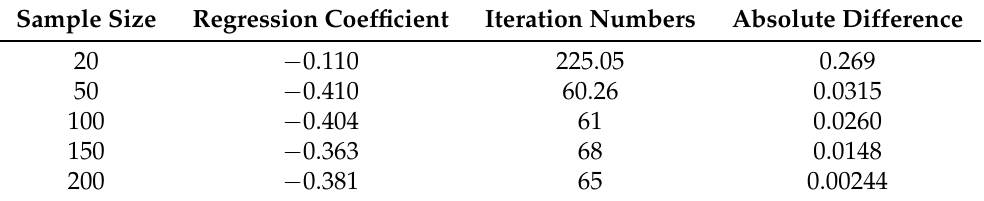
Table 2. The simulation results under different sample sizes. The last column shows the abso- lute difference between 2log ( ψ ( 3 )) and regression coefficients, given by | 2log ( ψ ( θ )) − Regres- sion coefficient |